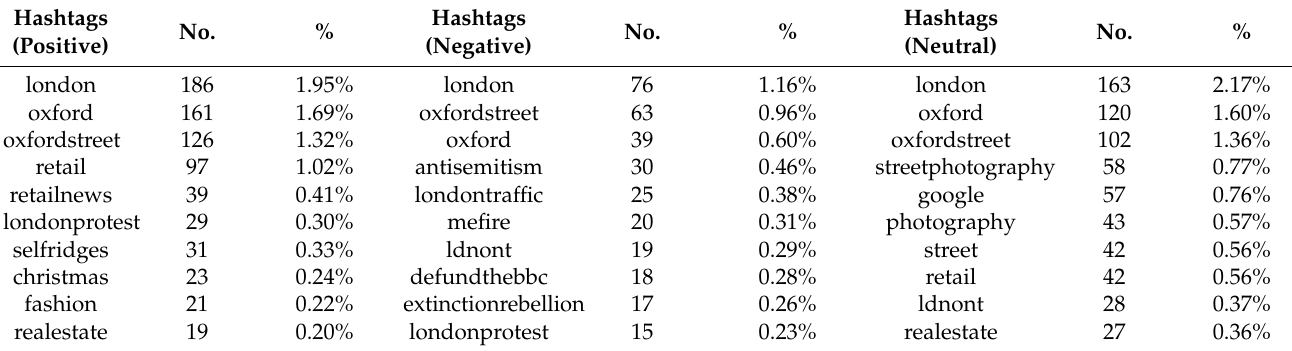
Table 3. Most frequently used related hashtags in